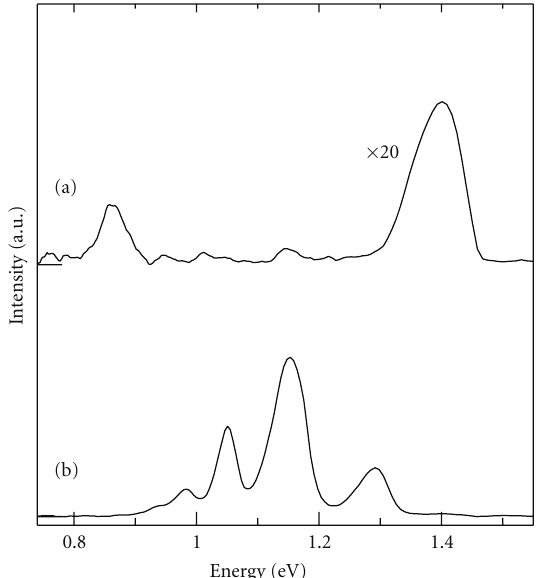
Figure 21: 4-K PL spectra of nanowire arrays with (a) 3- and (b) 0.4- μ m periods